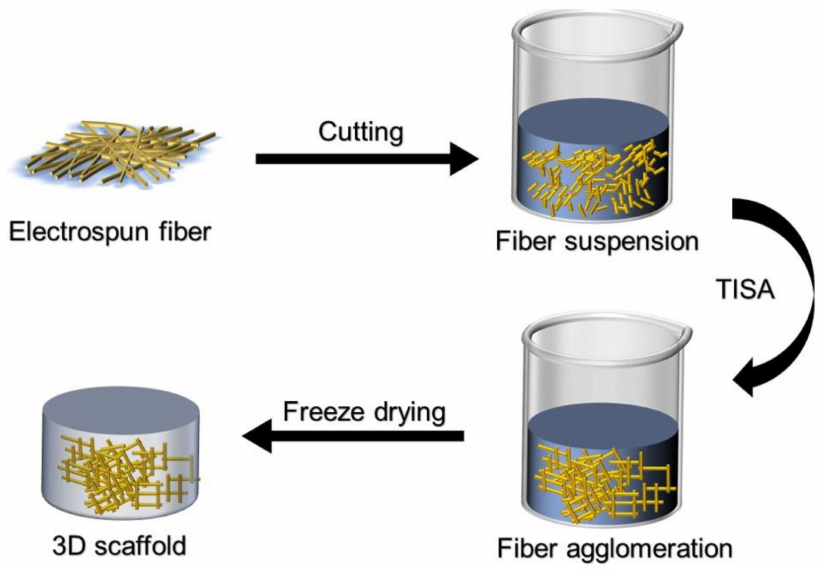
Figure 6. The illustration of building 3D electrospun fibrous scaffold via TISA and freeze drying